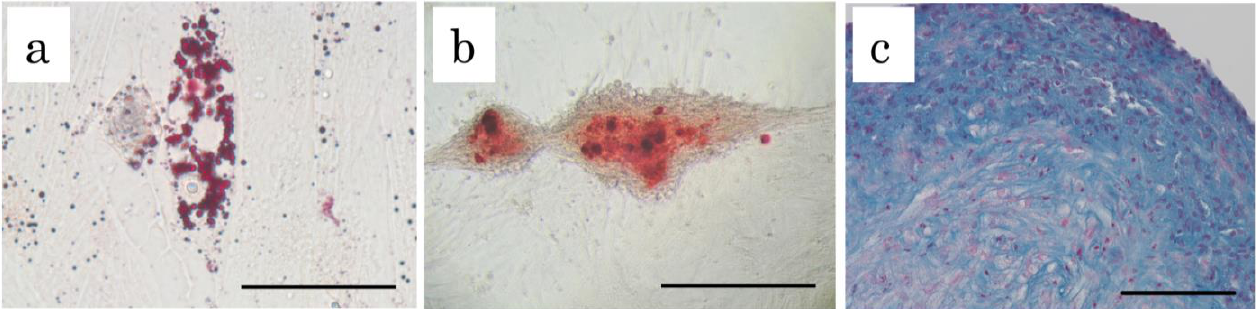
Figure 1. Differentiation of cADSC into three lineages. ( a ), Adipogenic differentiation identified by Oil Red O staining; ( b ), Osteogenic differentiation identified by Alizarin Red staining; ( c ), Chondrogenic differentiation identified by Alcian Blue. Bar = 100 μm.